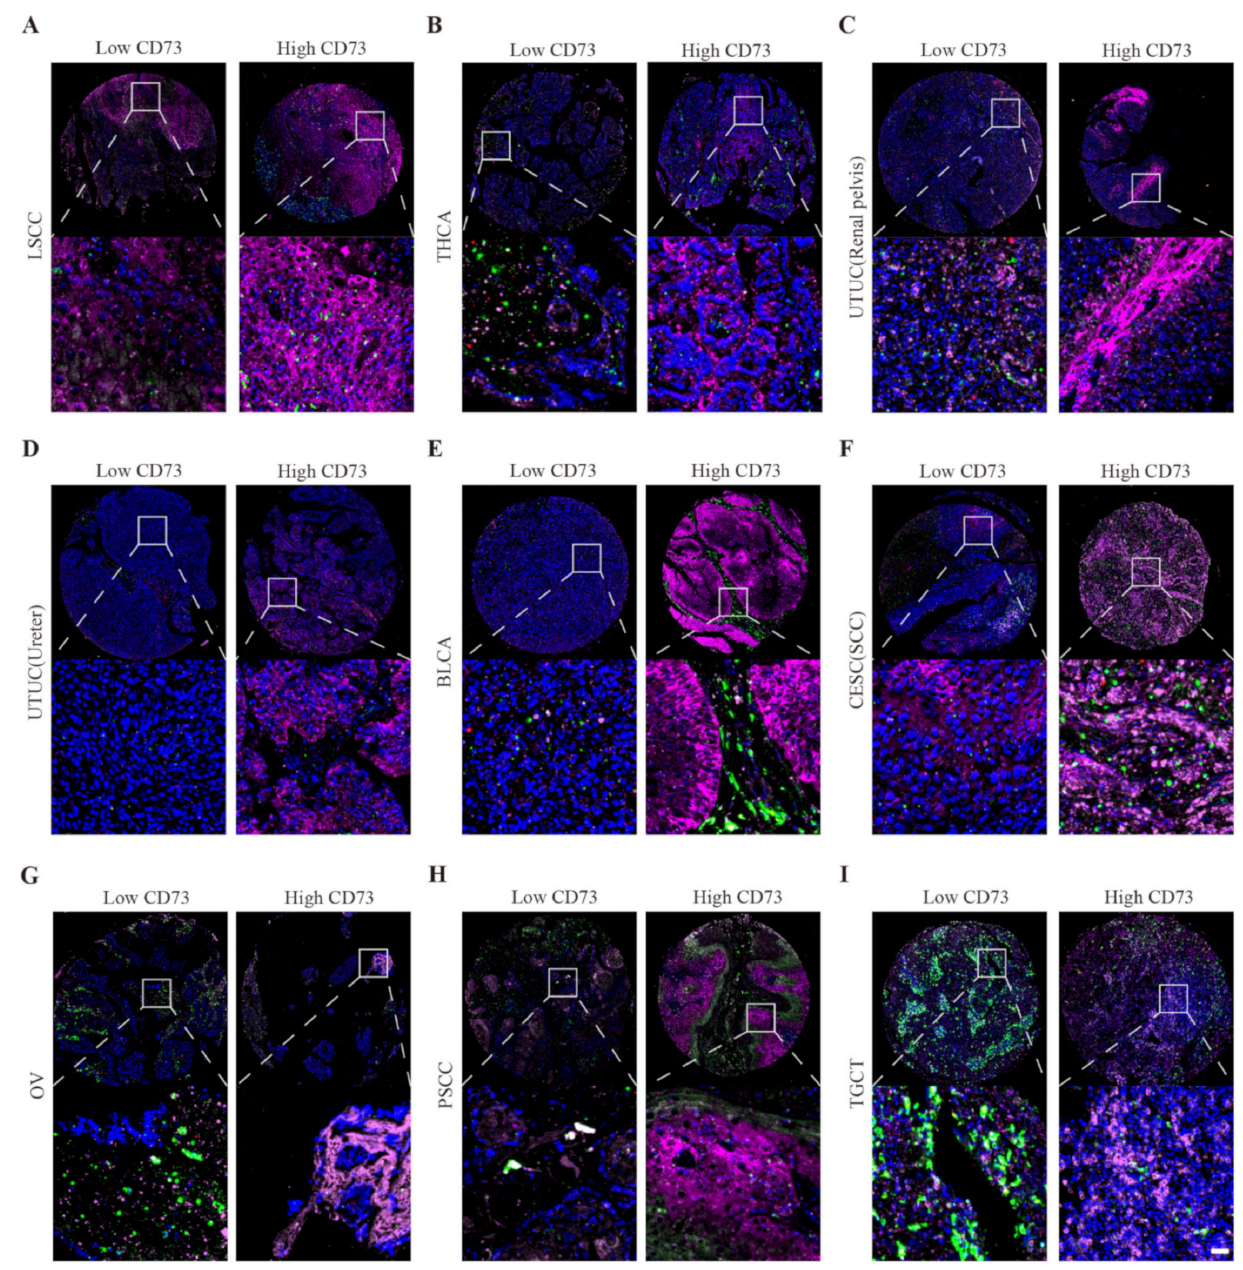
Figure 8. Triple immunofluorescences show high and low expression of CD73. Low and high CD73 expression in LSCC ( A ), THCA ( B ), UTUC ( C , D ), BLCA ( E ), CESC ( F ), OV ( G ), PSCC ( H ), and TGCT ( I ). Scale bar = 40 µ